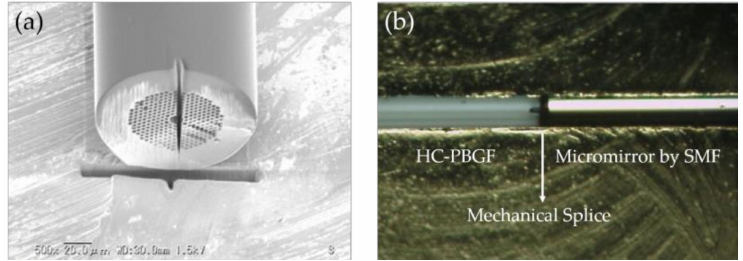
Figure 11. ( a ) SEM image of a penetrated hole of 5 × 5 µ m 2 in an HC-PBGF. ( b ) Image of the mechanical connection between the PCF and the SMF with a micromirror [88].